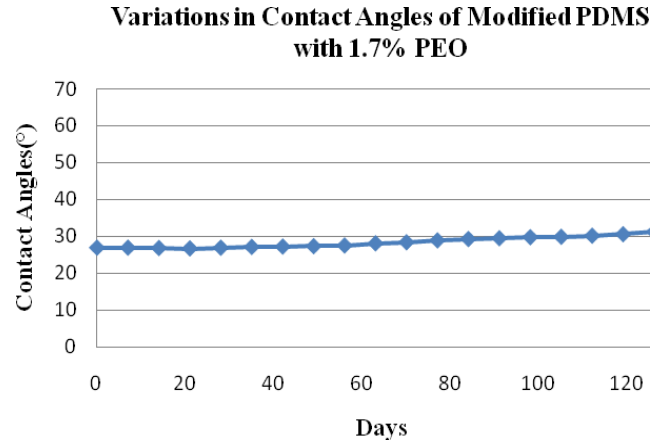
Figure 12. The curves are the days versus contact angles which illustrate the stability of the PEO-PDMS